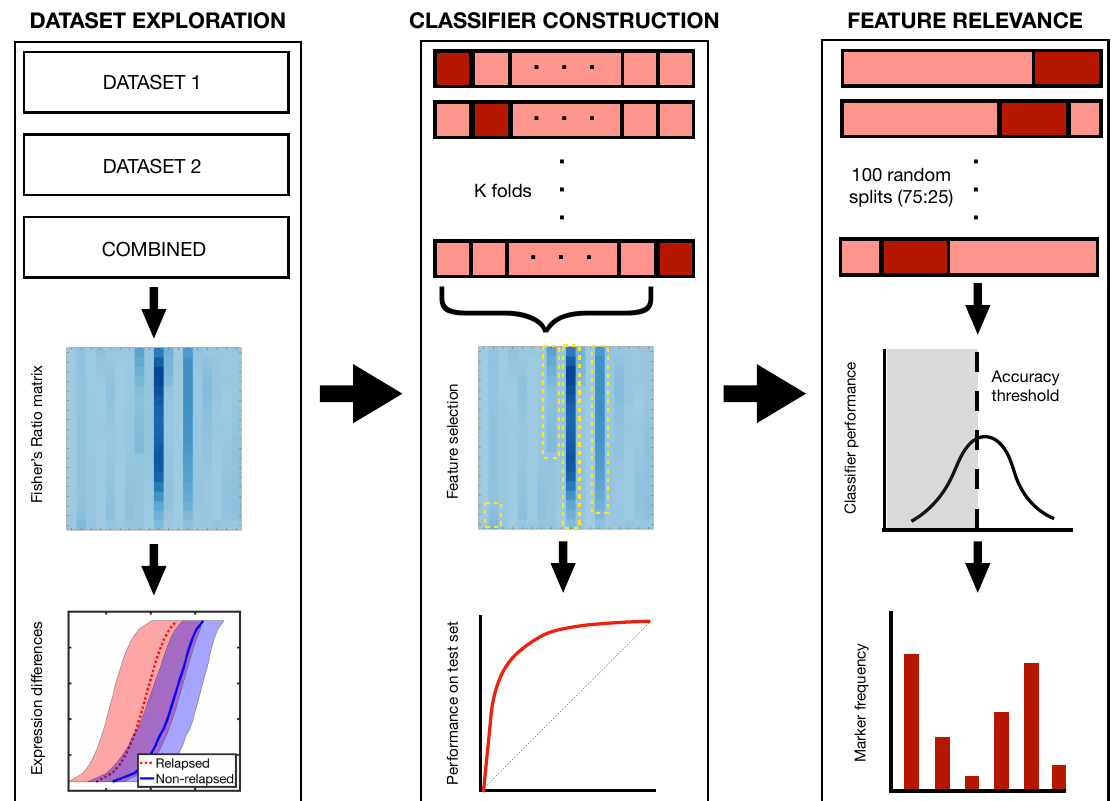
Figure 4. Main steps of the analysis with Fisher’s ratio. In step 1, we compute differences in marker expression between relapsing and non-relapsing patients, comparing the distributions of the most relevant markers. In step 2, we perform k-fold and Leave-One-Out cross-validation (LOOCV), constructing the classifiers with the most relevant markers of the respective train set. In step 3, we analyse the frequency with which markers are employed in 100 classifiers coming from 72:25 splits of the